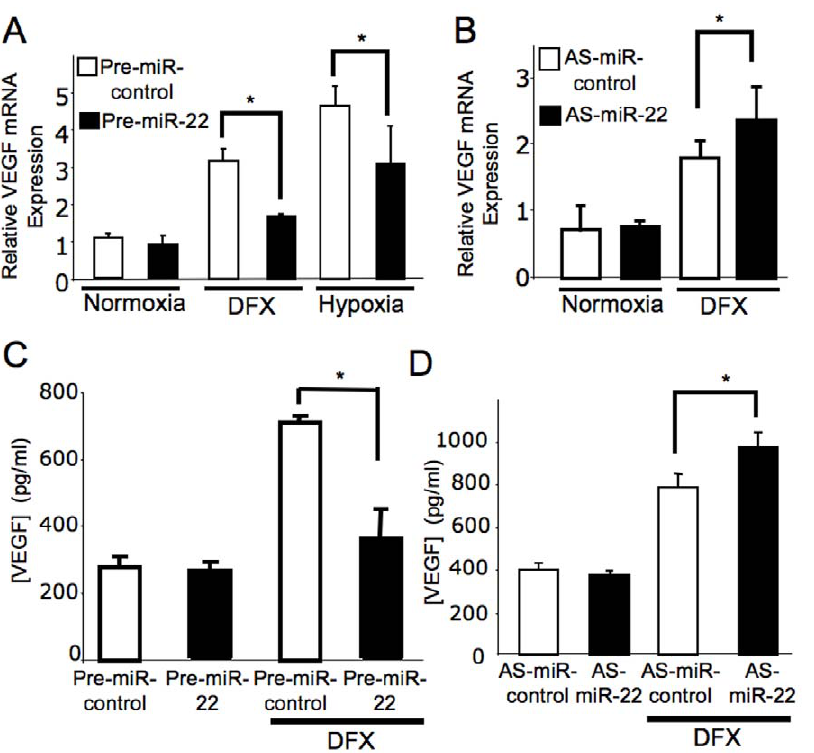
Figure 4. MiR-22 regulates VEGF expression and secretion. HCT116 were transfected with pre-miR-22 or anti-sense-miR-22 or control, and then exposed to normoxia or hypoxia for 16 h. The media was analyzed for VEGF by ELISA and RNA from cell lysates was analyzed for VEGF mRNA by qPCR (n=3 6 S.D. *P , 0.05) (A) Pre-miR-22 decreases VEGF mRNA. (B) Anti-sense-miR-22 increases VEGF mRNA. (C) Pre-miR-22 decreases VEGF protein. (D) Anti-sense-miR-22 increases VEGF